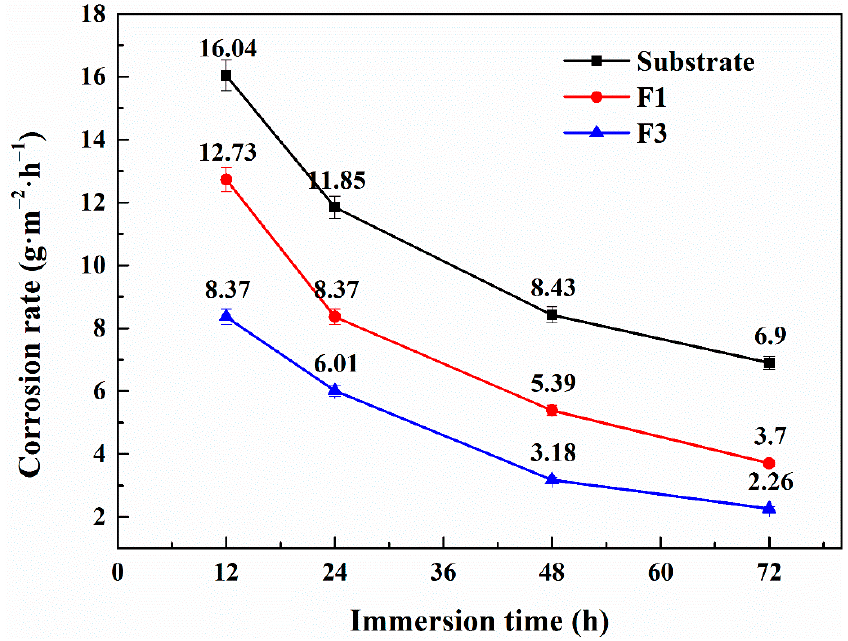
Figure 9. Corrosion rate curves of MAO coatings under different negative voltages.